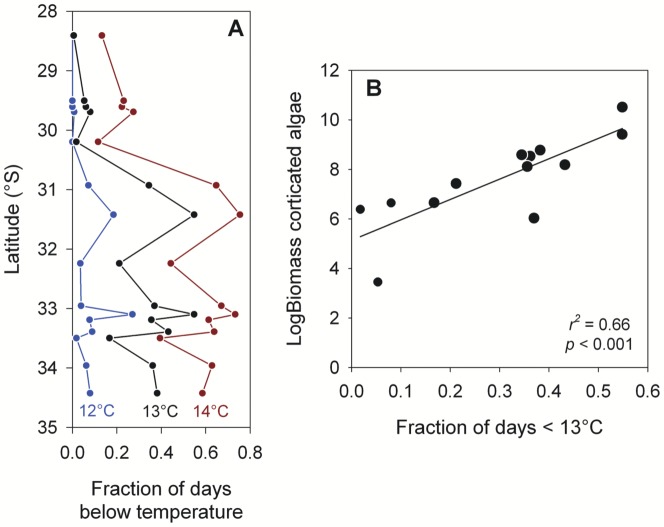
Spatial pattern in nearshore cooling and its relationship with algal biomass.(A) Latitudinal pattern in the summertime occurrence of temperature conditions indicative of high (12°C) to limiting (13°C) nitrate supply to shoreline habitats. (B) Association between cooling frequency (<13°C) and the biomass of corticated algae at a subset of the sites for which temperature records are available.